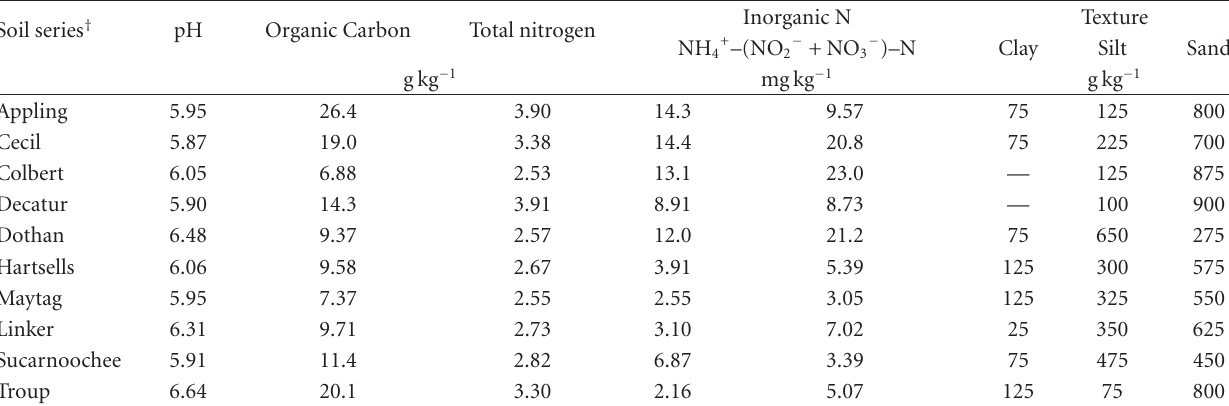
Table 1: Selected properties of the soils used † .